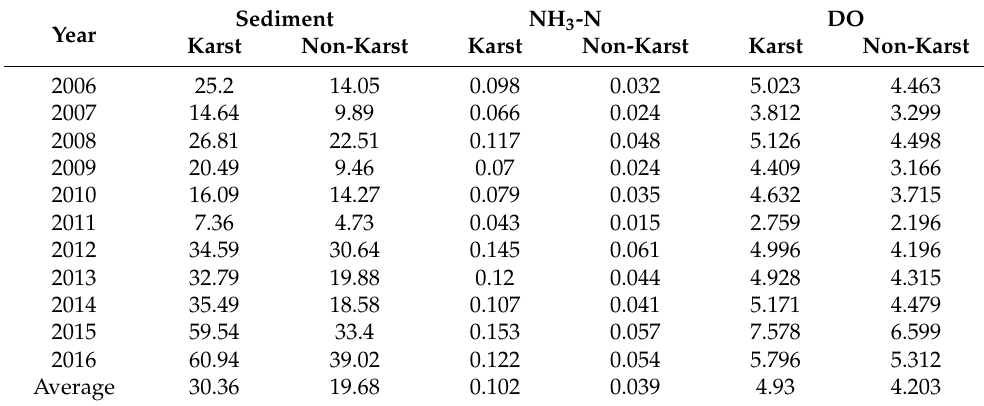
Table 6. Statistical table of unit pollution load in karst and non-karst areas (unit: t/km 2